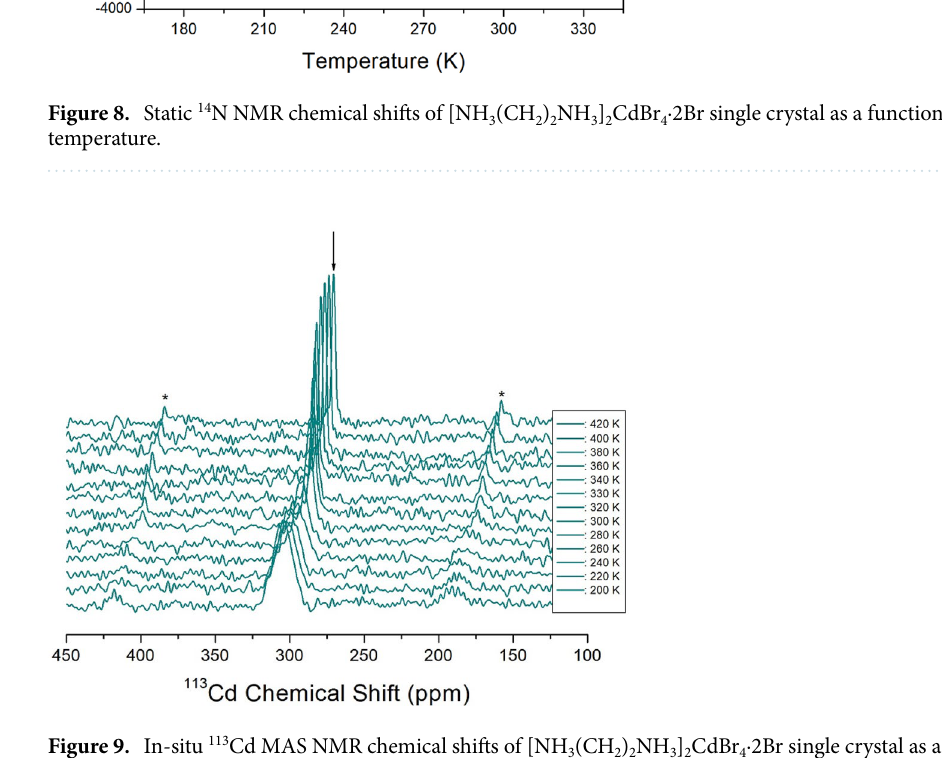
Figure 9. In-situ 113 Cd MAS NMR chemical shifts of [NH 3 (CH 2 ) 2 NH 3 ] 2 CdBr 4 ·2Br single crystal as a function of